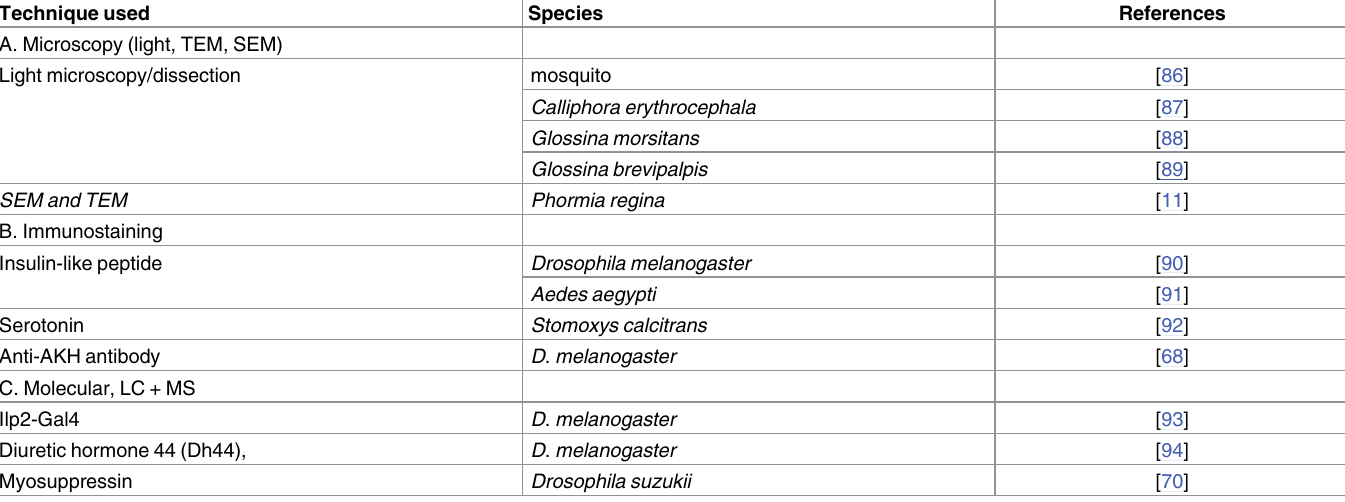
Table 2. Reports using various techniques (microscopy, antibodies or molecular probes, liquid chromatography (LC) and mass spectrometry (MS)) showing the nerve going to the crop and in some cases its